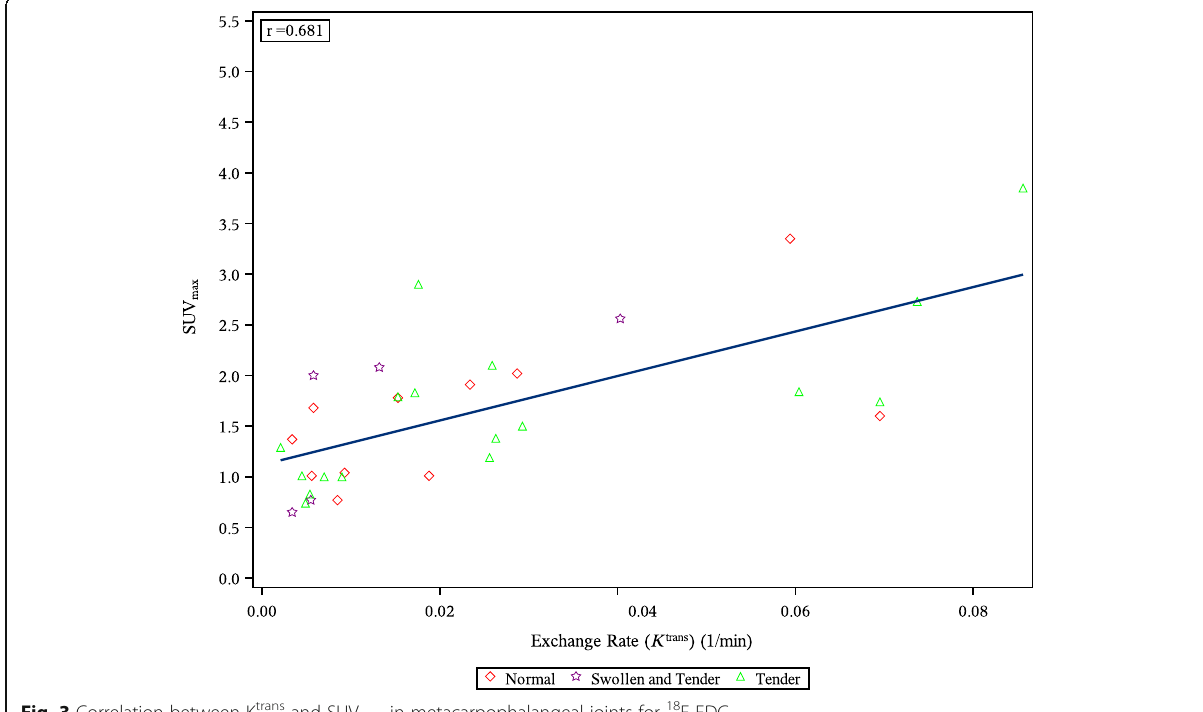
Fig. 3 Correlation between K trans and SUV max in metacarpophalangeal joints for 18 F-FDG